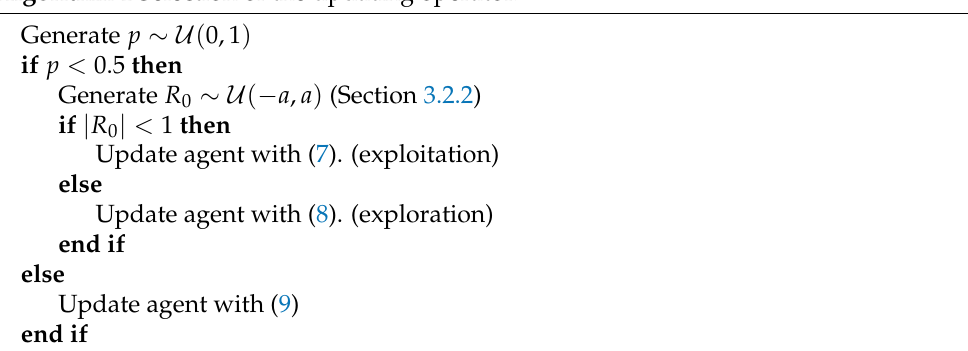
Algorithm 1 Selection of the updating